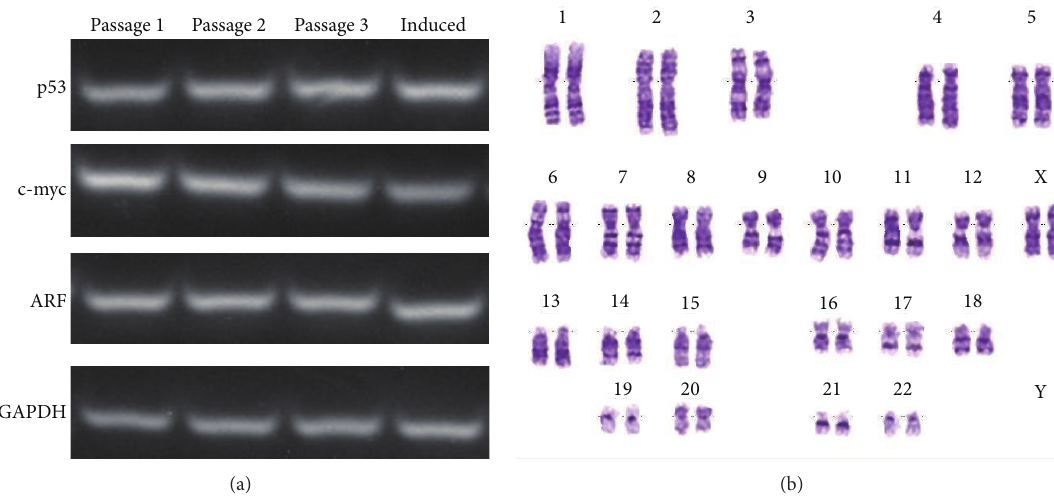
Figure 5: Genetic stability evaluation. (a) The expression levels of p53, ARF, and c-myc in aBMSCs were unchanged over time and under osteogenic induction. (The term “induced” denotes aBMSCs at passage 3 that were cultured on nHAC/PLA scaffolds in osteogenic induction medium.) (b) aBMSCs at passage 4 that were cultured on nHAC/PLA in osteogenic induction medium exhibited a normal